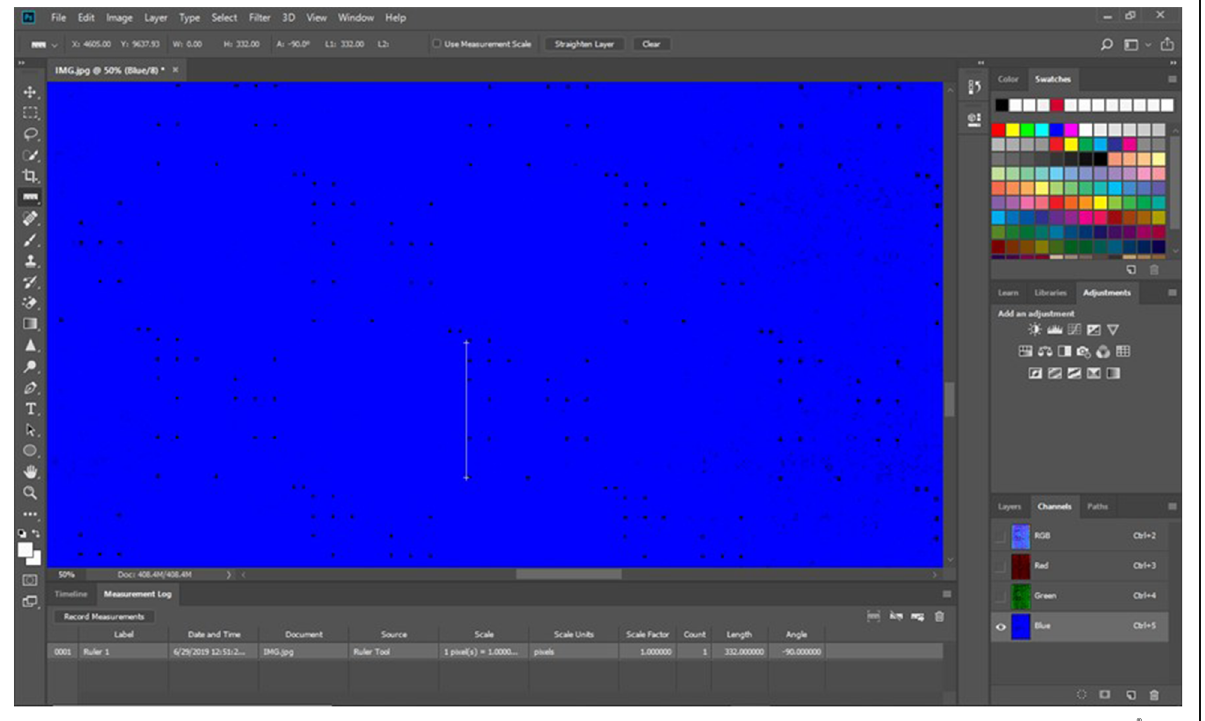
Fig. 3 The measurement of the length of the basic coded dot matrix pattern in the RGB mode of color laser printout of laser Ricoh ® SP 420 sample